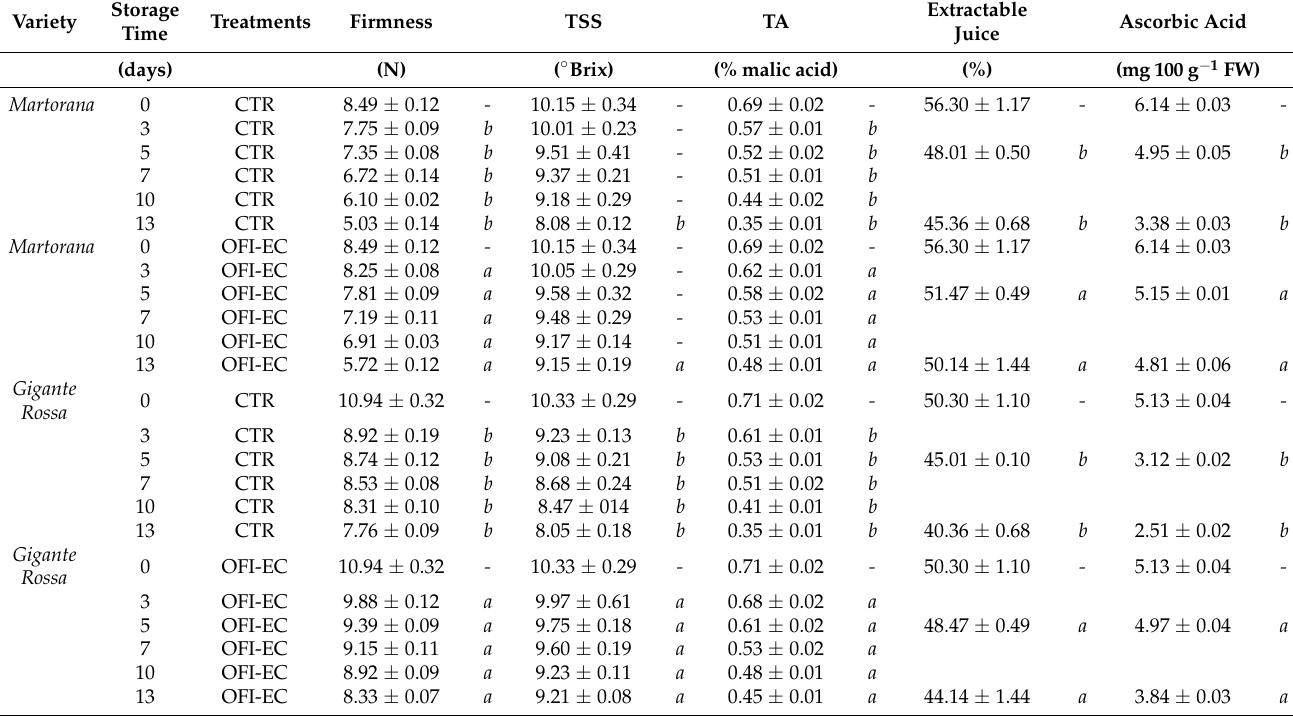
Table 1. Changes in firmness, total soluble solids (TSS) titratable acidity (TA), extractable juice, and ascorbic acid content in minimally processed loquat fruits (cv Martorana and cv Gigante Rossa ), untreated (CTR) samples, and those treated with mucilage (OFI-EC) during cold storage (13 days at 5 ◦ C). Different lowercase letters indicate significant differences at p ≤ 0.05 between the treatments on each sampling date. Data are the mean ± SE ( n =